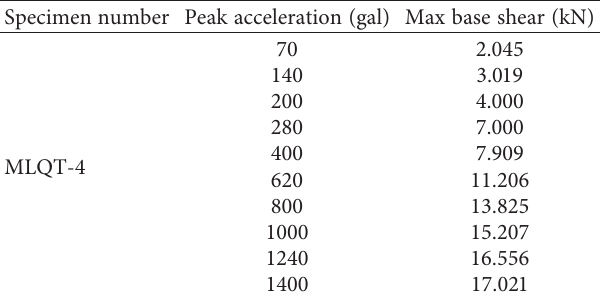
Table 8: Maximum shear with peak acceleration